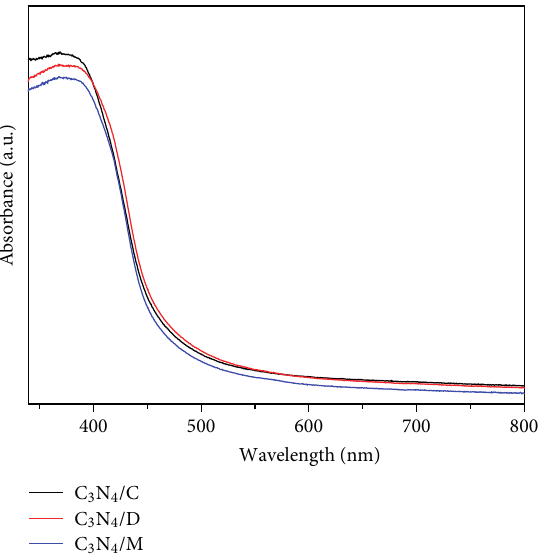
F 3: UV-visible absorption spectra of g-C